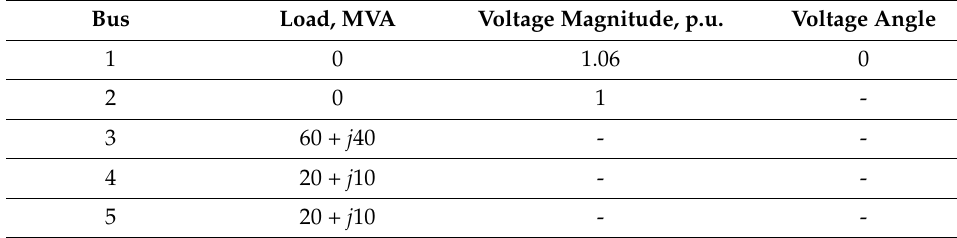
Table 2. Line data in the five-bus system.